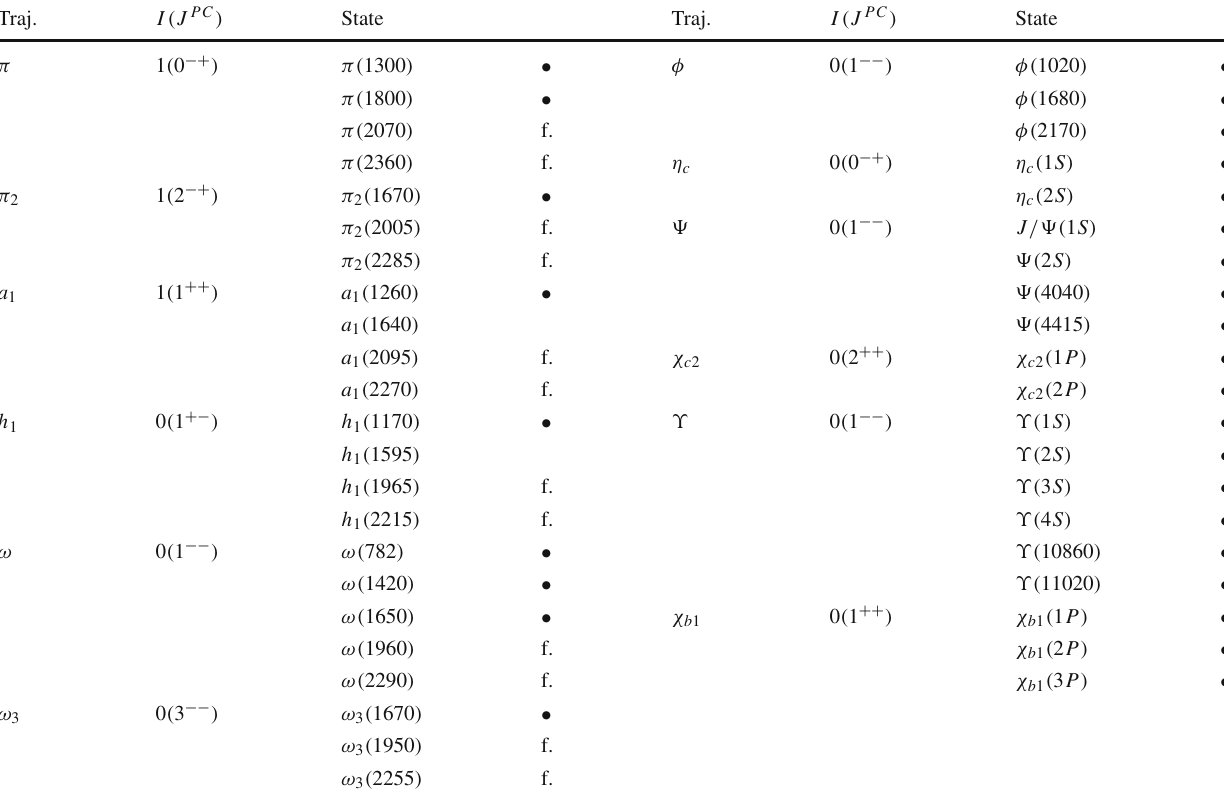
Table 15 All the meson states on radial trajectories used in our fits. The fourth column indicates the status given to each state by the PDG. States marked with a bullet are well established, while those marked with an “f.” are listed as further states, which need confirmation Traj.